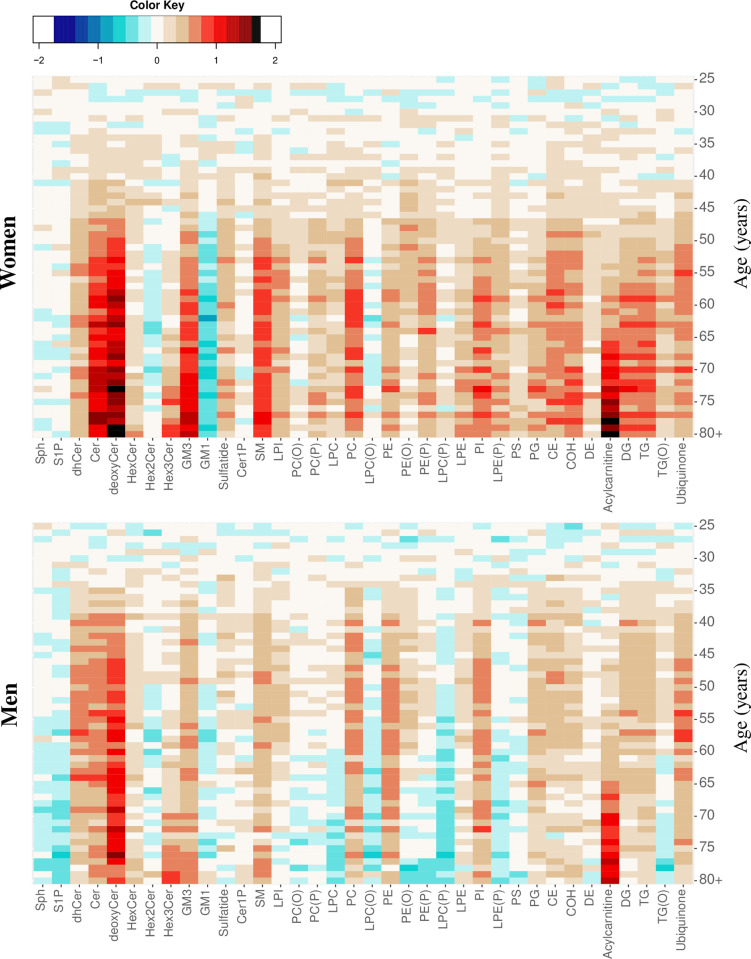
Age- and sex-related differences in plasma lipid classes in the AusDiab cohort.Heat maps showing differences in lipid class/subclass levels across a 1-year age interval constructed separately for men (lower panel) and women (upper panel) after adjusting for BMI. Average lipid class levels were calculated for each 1-year age interval and then centred and scaled to a ‘reference’ group corresponding to 25- to 34-year–old participants. Age groups (by 1-year intervals) are displayed on the y axis and the lipid classes on the x axis. Colour intensities represent the number of standard deviations away from the mean lipid class levels of the reference group. AusDiab, Australian Diabetes, Obesity and Lifestyle Study; BMI, body mass index; CE, cholesteryl ester; Cer, ceramide; Cer-1-P, ceramide-1-phosphate; COH, free cholesterol; DE, dehydrocholesterol; deoxyCer, deoxyceramide; DG, diacylglycerol; dhCer, dihydroceramide; GM1, GM1 ganglioside; GM3, GM3 ganglioside; HexCer, monohexosylceramide; Hex2Cer, dihexosylceramide; Hex3Cer, trihexosylceramide; LPC, lysophosphatidylcholine; LPC(O), lysoalkylphosphatidylcholine; LPC(P), lysoalkenylphosphatidylcholine; LPE, lysophosphatidylethanolamine; LPE(P), lysoalkenylphosphatidylethanolamine; LPI, lysophosphatidylinositol; PC, phosphatidylcholine; PC(O), alkylphosphatidylcholine; PC(P), alkenylphosphatidylcholine; PE, phosphatidylethanolamine; PE(O), alkylphosphatidylethanolamine; PE(P), alkenylphosphatidylethanolamine; PG, phosphatidylglycerol; PI, phosphatidylinositol; PS, phosphatidylserine; SM, sphingomyelin; Sph, sphingosine; S-1-P, sphingosine-1-phosphate; TG, triacylglycerol; TG(O), alkyl-diacylglycerol.